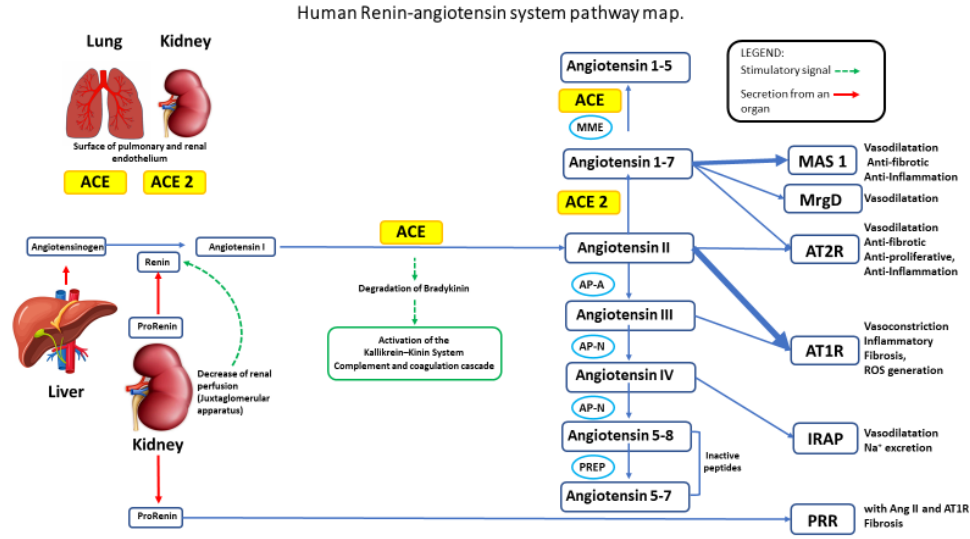
Figure 1. Cartoon summarizing the molecular factors involved in the Renin–angiotensin–aldosterone